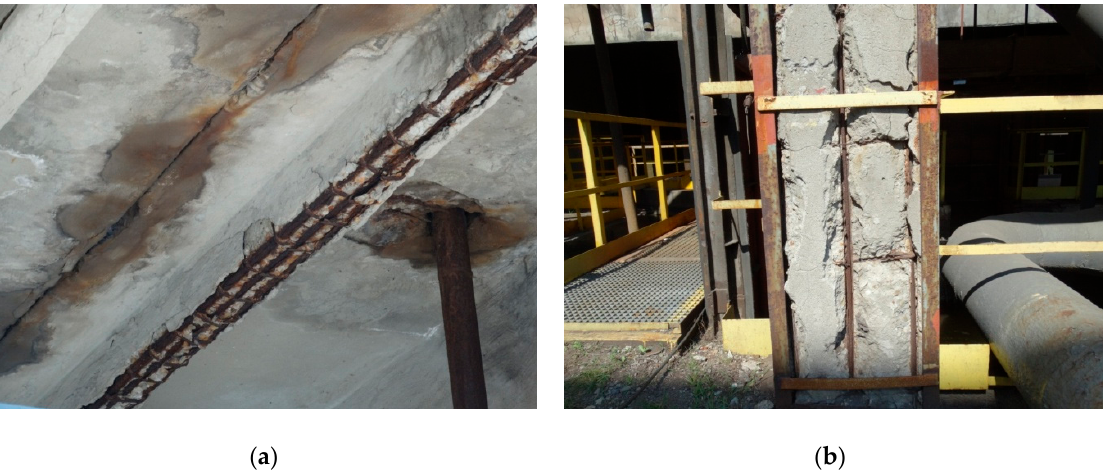
Figure 6. The very bad condition of structural elements: ( a ) swelling steel rebars caused damage of the concrete cover, ( b ) damaged steel strengthening and concrete of columns.